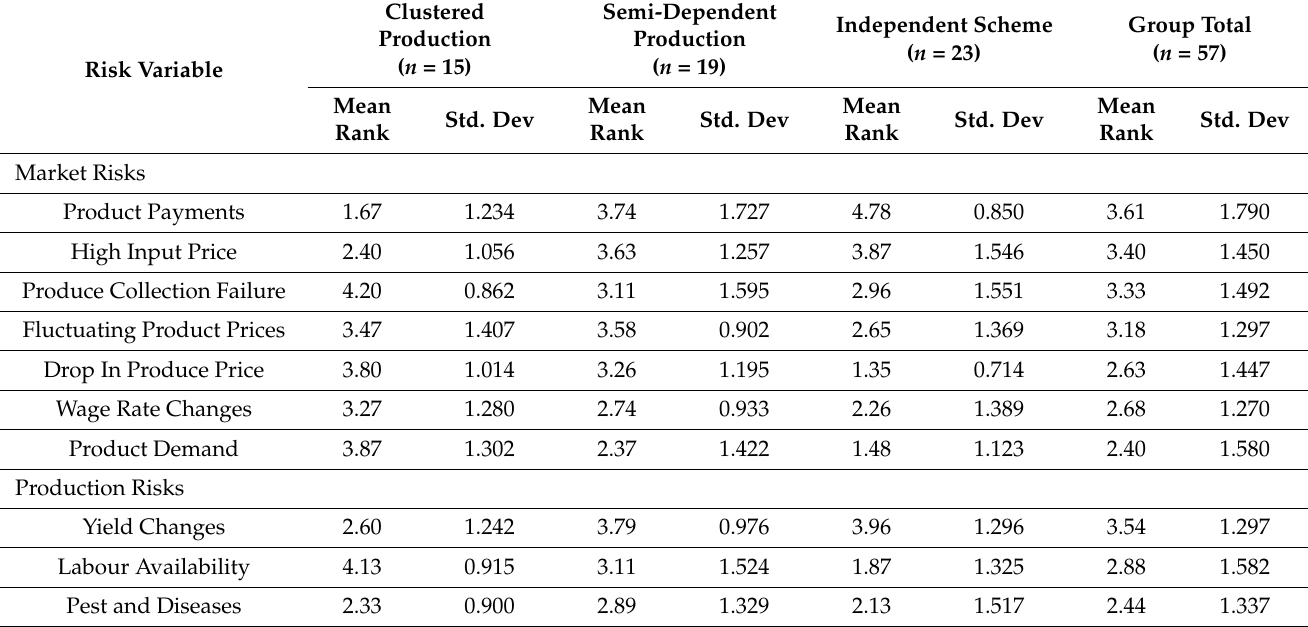
Table 1. Risk factor loading on